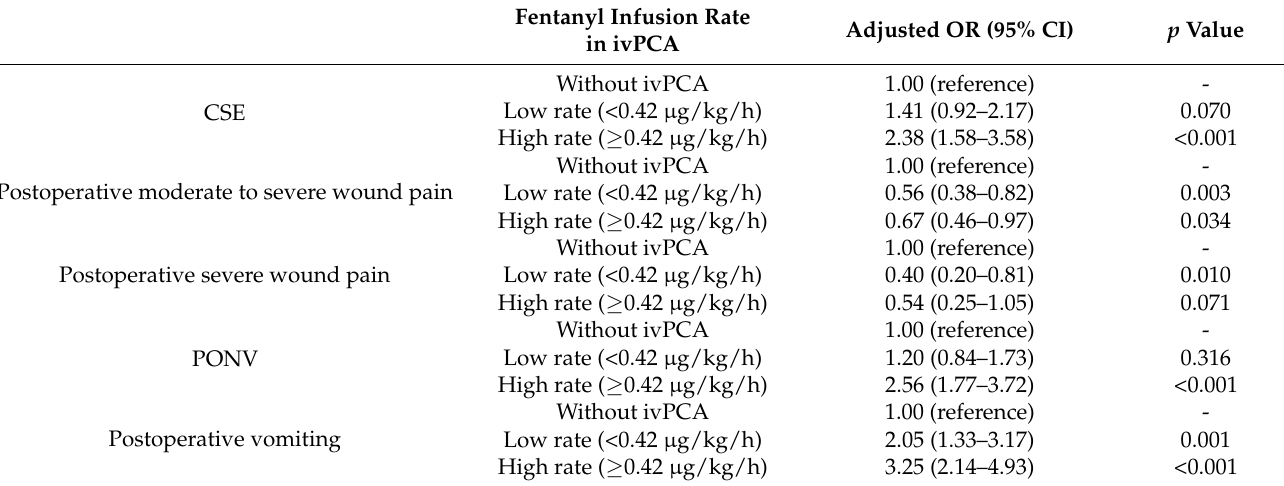
Table 4. Association between fentanyl infusion rate in ivPCA and outcomes.